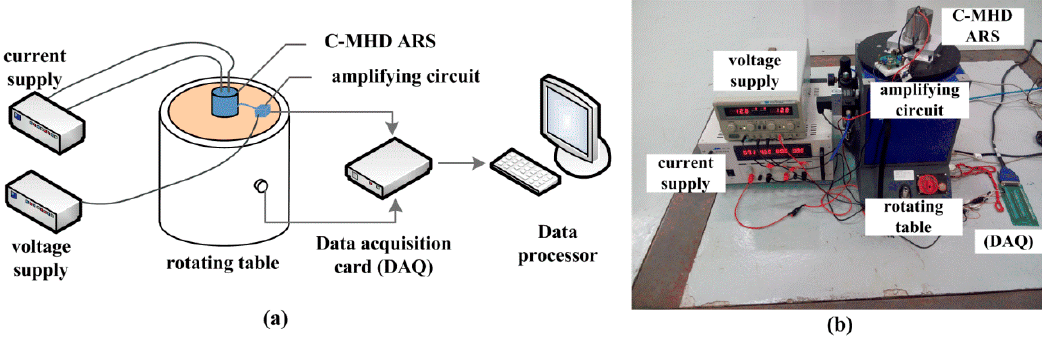
Figure 13. Frequency response experiment designed for C-MHD ARS. ( a ) Sketch Map ( b ) Physical map.